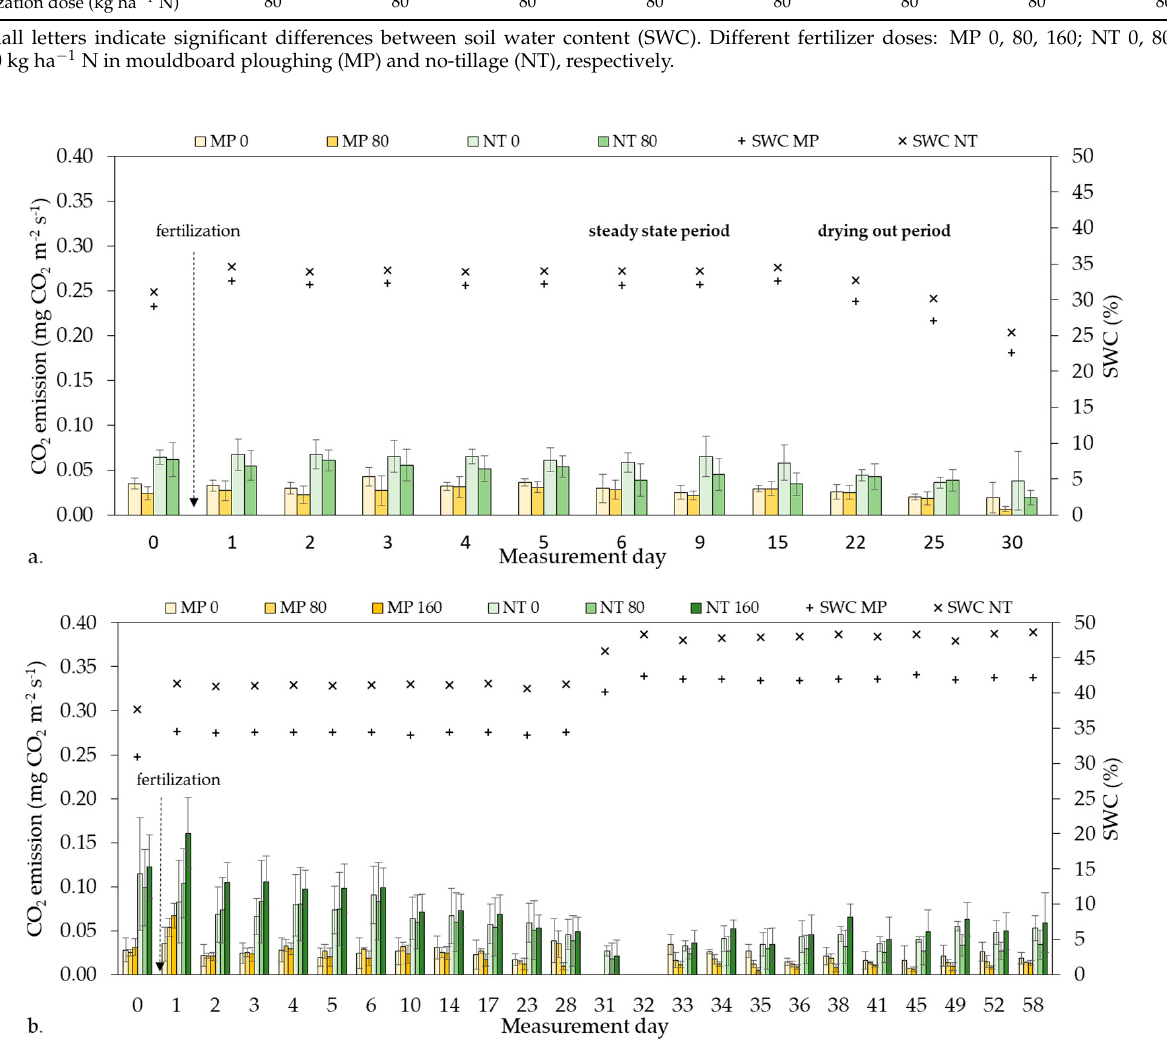
Figure 1. The course of CO 2 emission in the laboratory experiments: ( a ) tillage experiment and ( b ) fertilizer experiment. Different fertilizer doses: MP0, 80, 160; NT 0, 80, 160 kg ha − 1 in mouldboard ploughing (MP) and no-tillage (NT), respectively. SWC—soil water content.